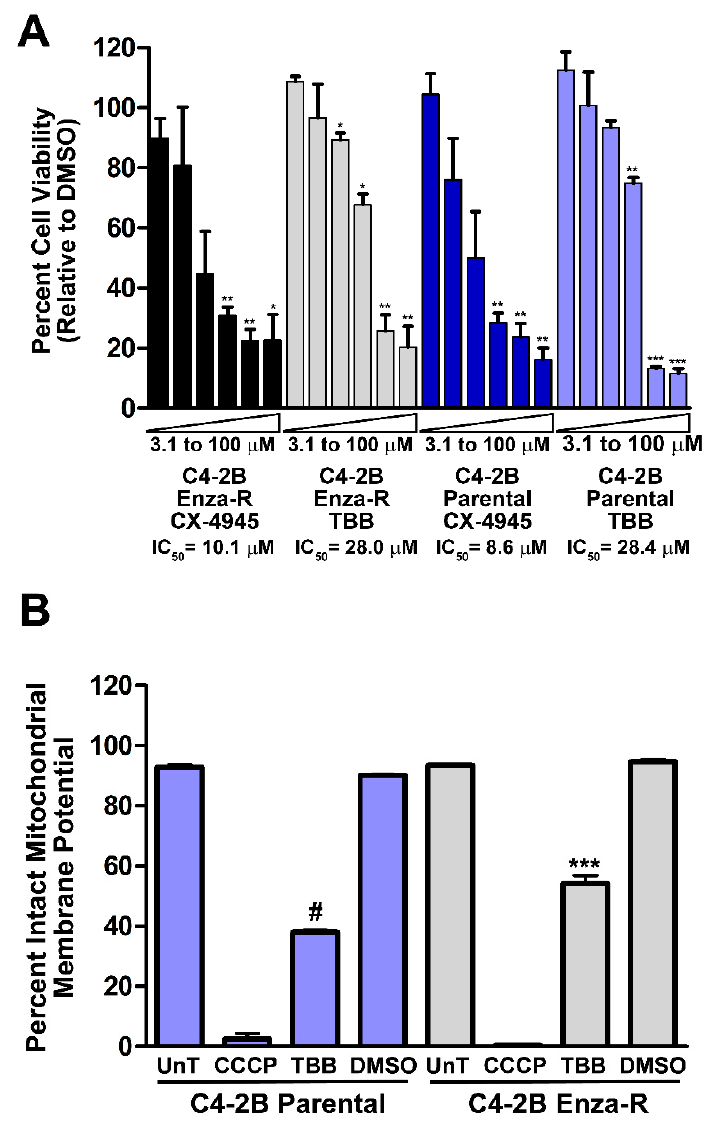
Figure 8. CK2 inhibition decreases cell viability and induces loss of mitochondrial membrane potential in enzalutamide-resistant C4-2B prostate cancer cells. ( A ) C4-2B parental and enzalutamide-resistant cells were treated with 2-fold dilution series of TBB, CX-4945 or equivalent concentrations of DMSO for 72 h. Cell viability was measured by MTS-based Aqueous One assay. Experiment was performed three times. Error bars indicate standard error. * p < 0.05; ** p < 0.01; *** p < 0.001; # p < 0.0001. ( B ) C4-2B parental and enzalutamide-resistant cells were treated with 50 µ M TBB, or equivalent volume DMSO for 2 h. JC-1 was added to the cells 1 h after TBB or DMSO addition. CCCP treatment at 50 µ M for the last 30 min of incubation was used as positive control. Experiment was performed three times. Error bars indicate standard error. *** p < 0.001; # p < 0.0001.